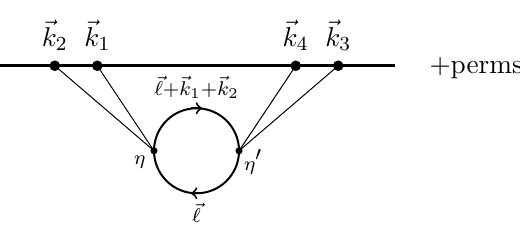
Figure 20 . 1-loop 4-point Witten diagrams obtained in (6.15).